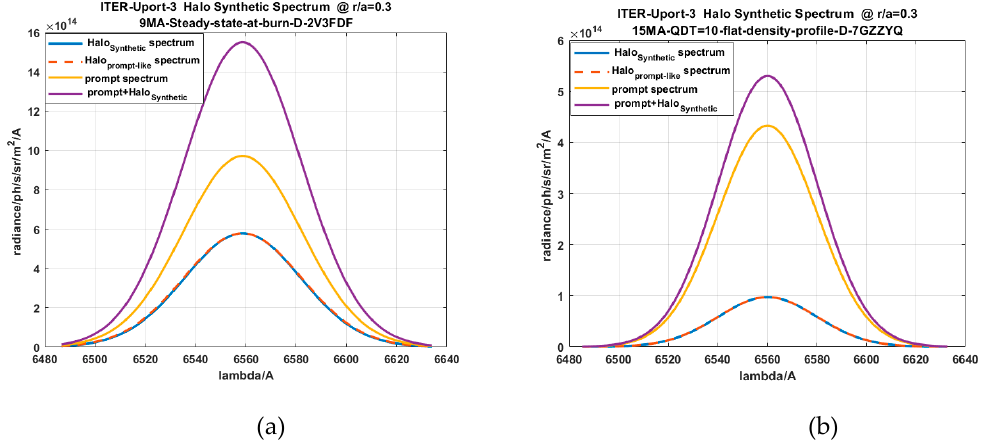
Figure 14. ( a ) D α Spectrum with prompt signal and comparison of Gaussian-like halo shape and Synthetic l.o.s. integrated halo shape. 9MA_Steady_state_at_burn_D_2V3FDF; ( b ) D α Spectrum with prompt signal and comparison of Gaussian-like halo shape and Synthetic l.o.s. integrated halo shape.